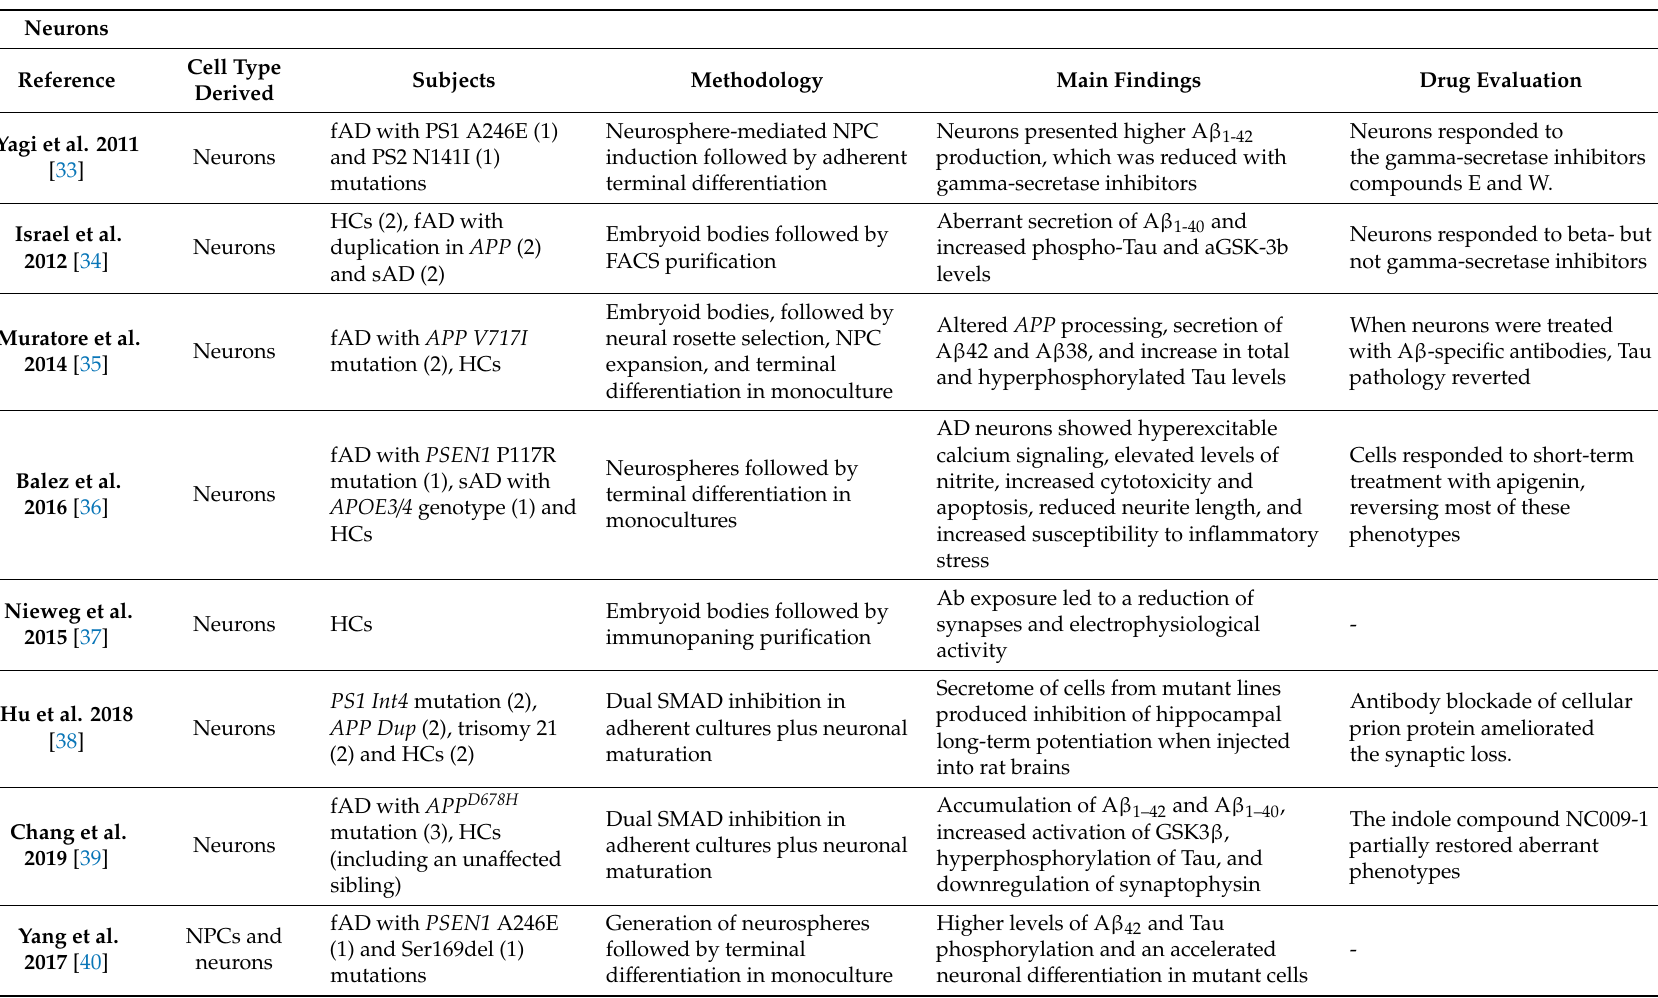
Table 1. Summary of the findings of the main studies describing the generation of hPSC-derived neurons from patients with Alzheimer’s